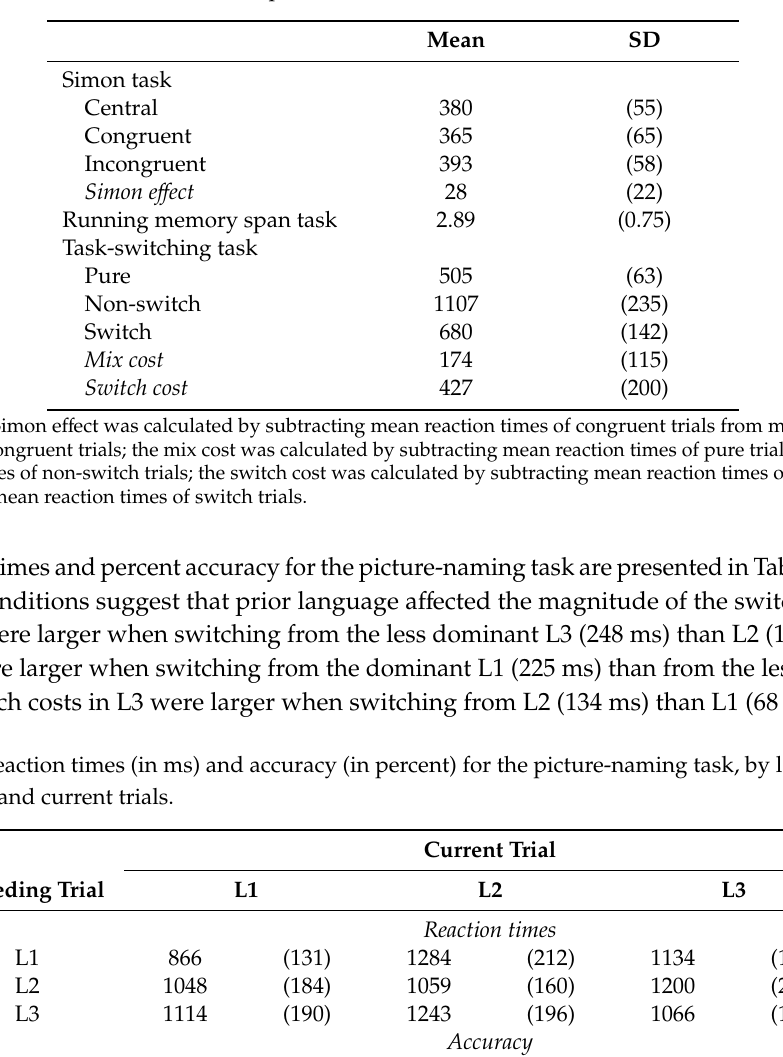
Table 2. Means (SDs) of performance on the executive function (EF) tasks.